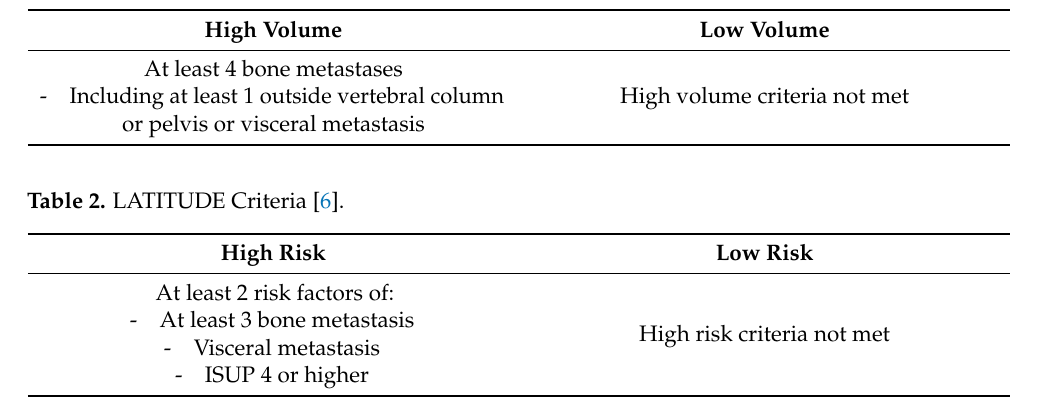
Table 1. CHAARTED criteria [5].